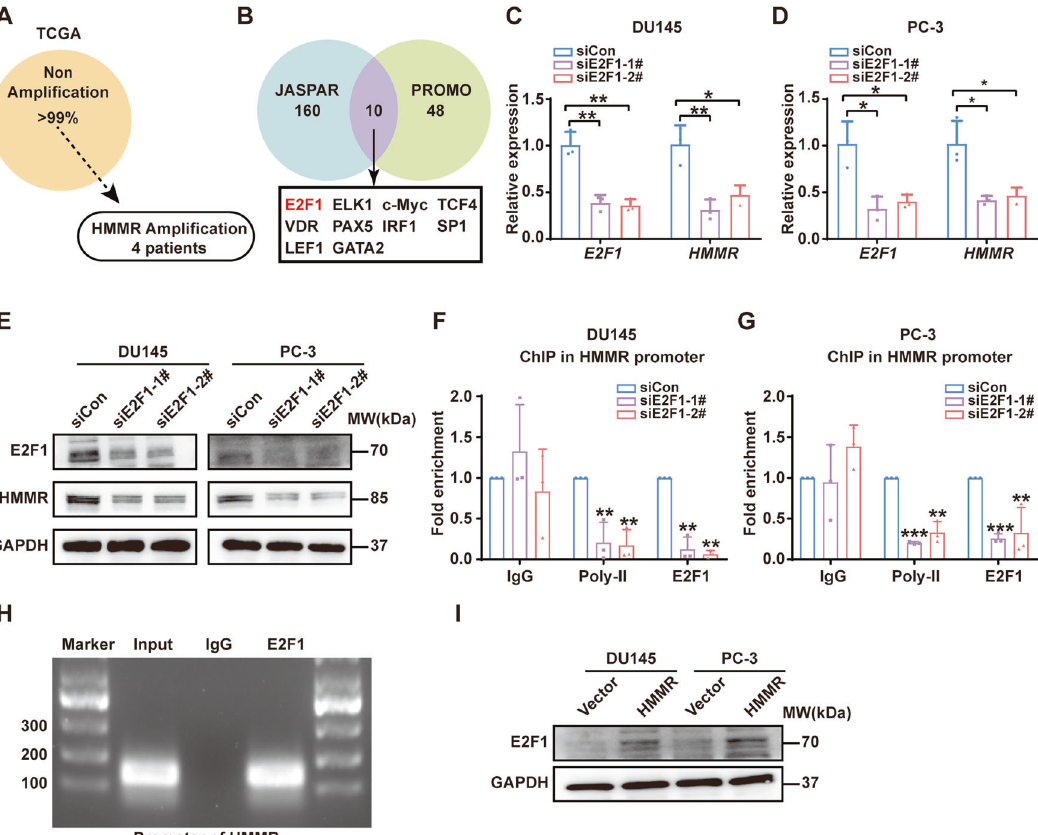
Fig. 6 HMMR upregulated E2F1 and in turn promoted HMMR transcription to form a positive feedback loop. A Analysis of HMMR ampli fi cation mutation in TCGA. B Potential upstream TFs of HMMR predicted by JASPAR and PROMO. C , D qRT – PCR analysis of HMMR mRNA after transfection with E2F1-speci fi c siRNA (siE2F1-1#, siE2F1-2#) in DU145 ( C ) and PC-3 ( D ) cells. E Western blotting analysis of HMMR after E2F1 knockdown. F – H ChIP-qPCR ( F – G ) and gel electrophoresis ( H ) analysis of Pol-II status in the promoters of HMMR and HMMR transcriptional activity after E2F1 knockdown in DU145 cells. I Western blotting analysis of E2F1 in the HMMR overexpression group of DU145 and PC-3 cells. * p < 0.05, ** p < 0.01, *** p <